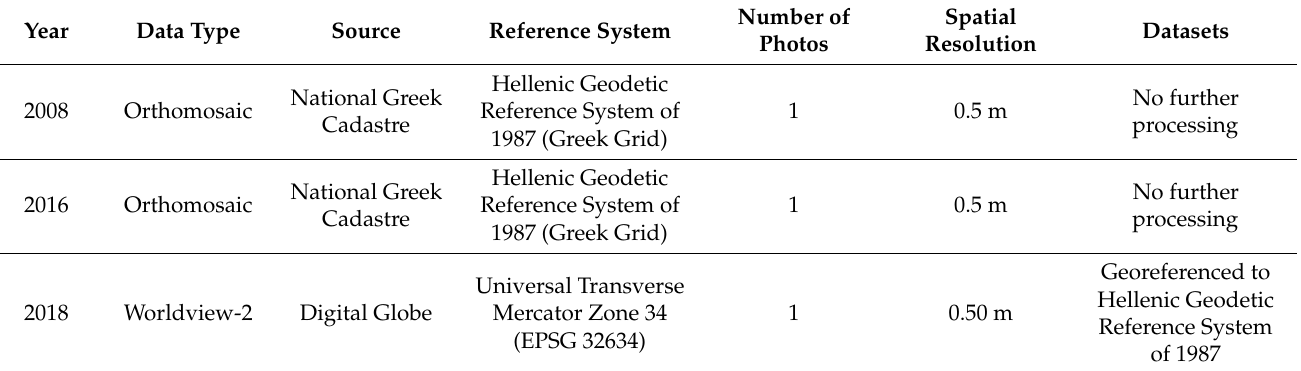
Table 2. Remote-sensing data retrieved with their